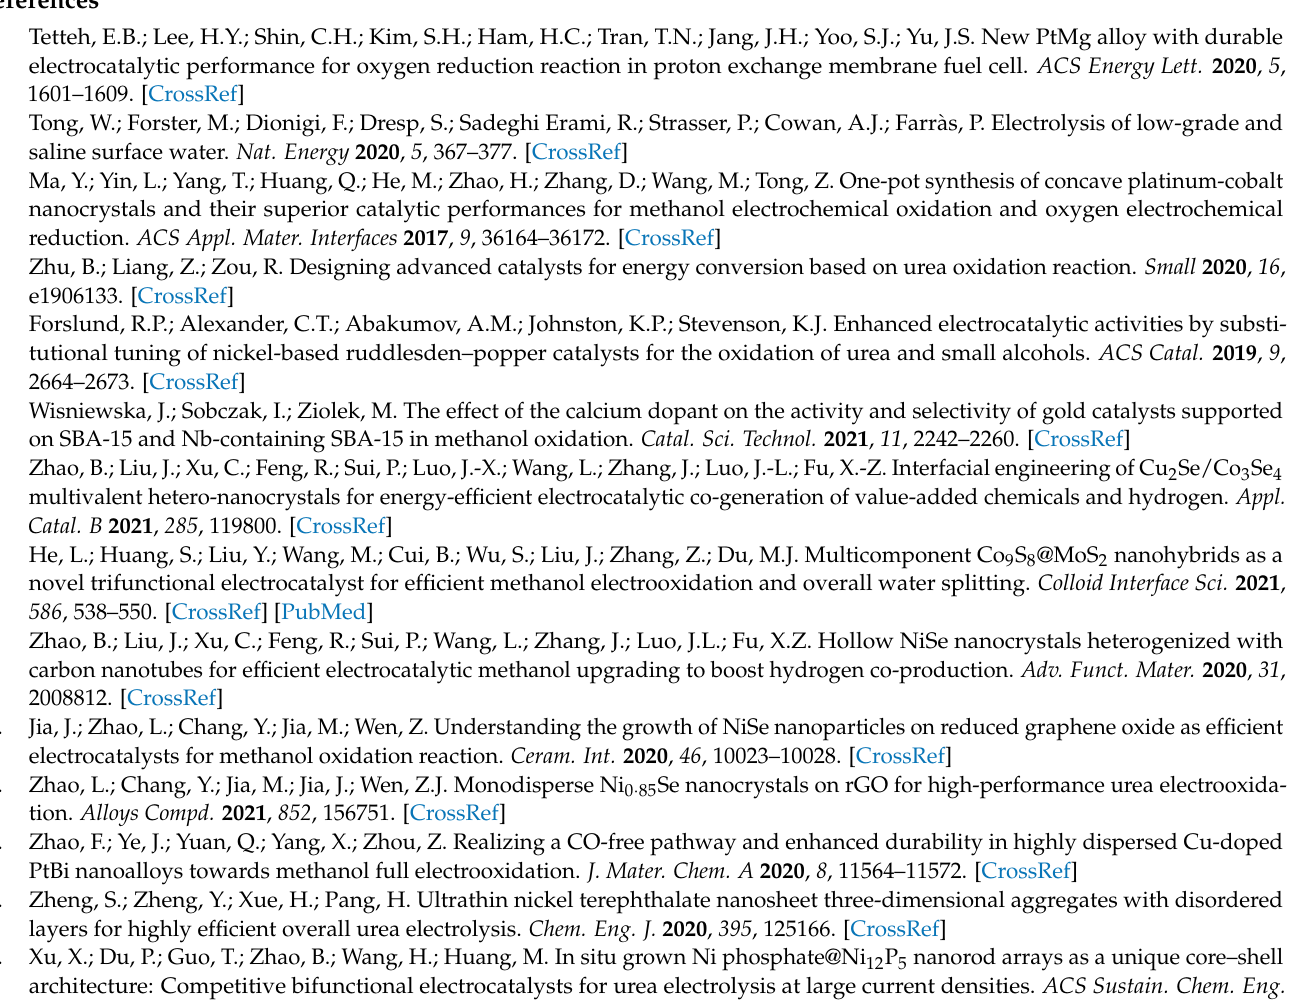
double-layer capacitance over a range of scan rates, Table S1: The MOR performance, Table S2: The UOR performance, Table S3: Content of different element in 3D-C-NiCo